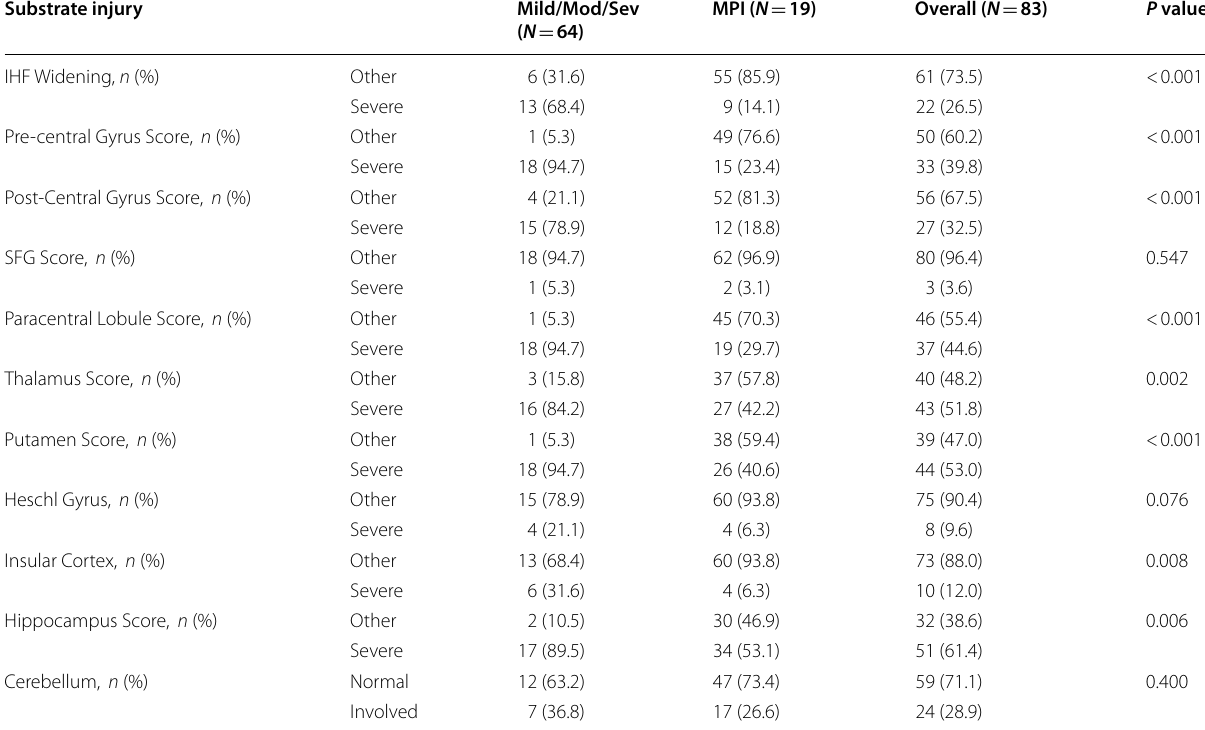
Table 7 Key features of each subtype of parasagittal central hypoxic–ischaemic injury